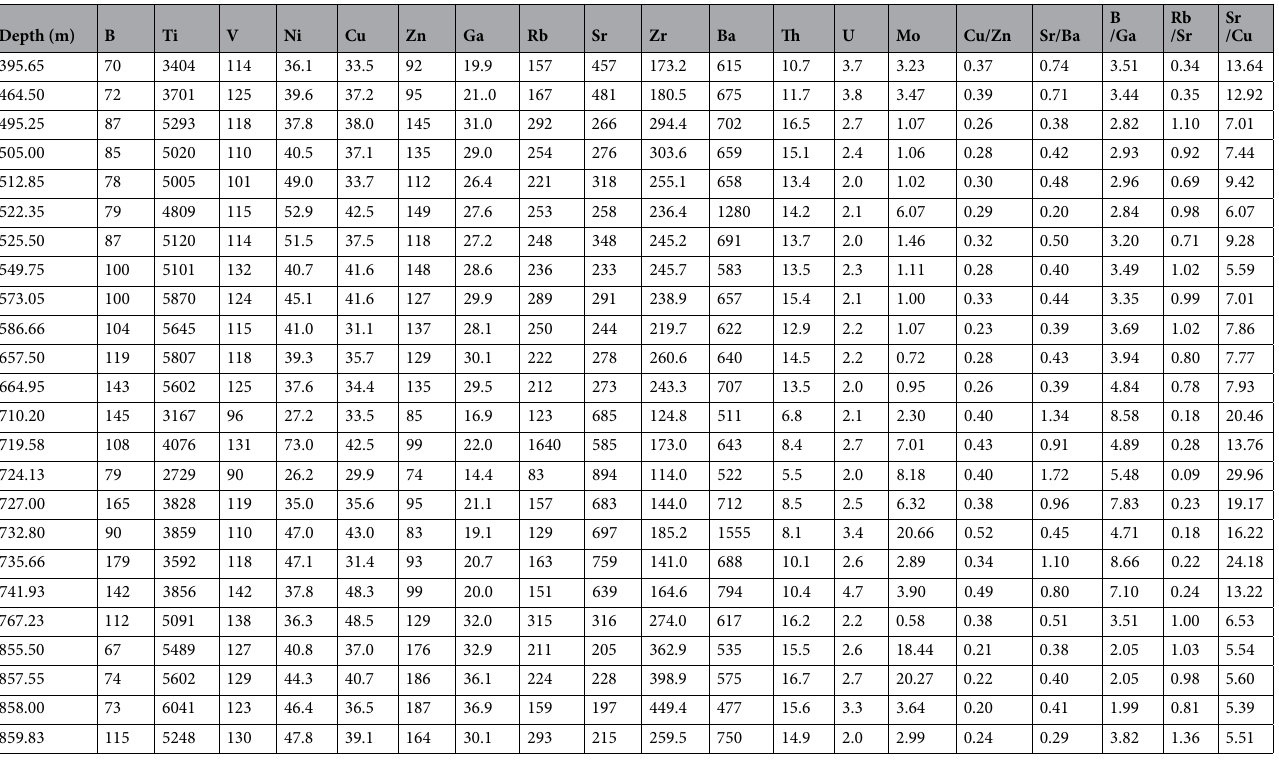
Table 3. Trace element geochemistry (in μg/g) of the Xiahuapidianzi Formation mudstone